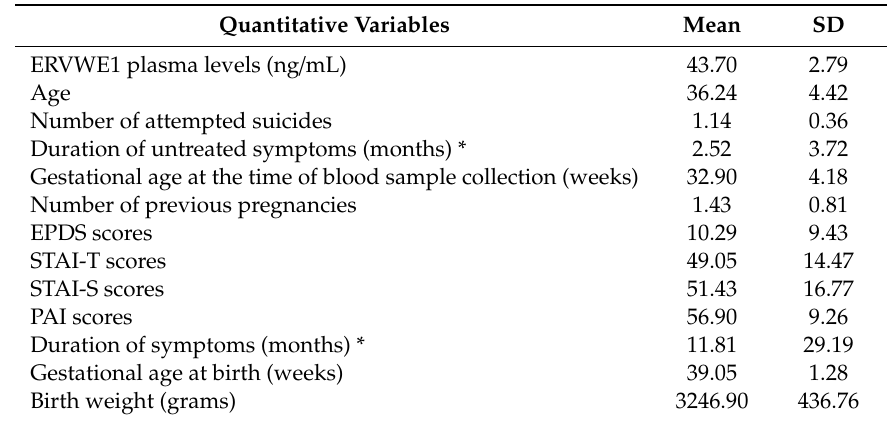
Table 1. Descriptive analyses of the total